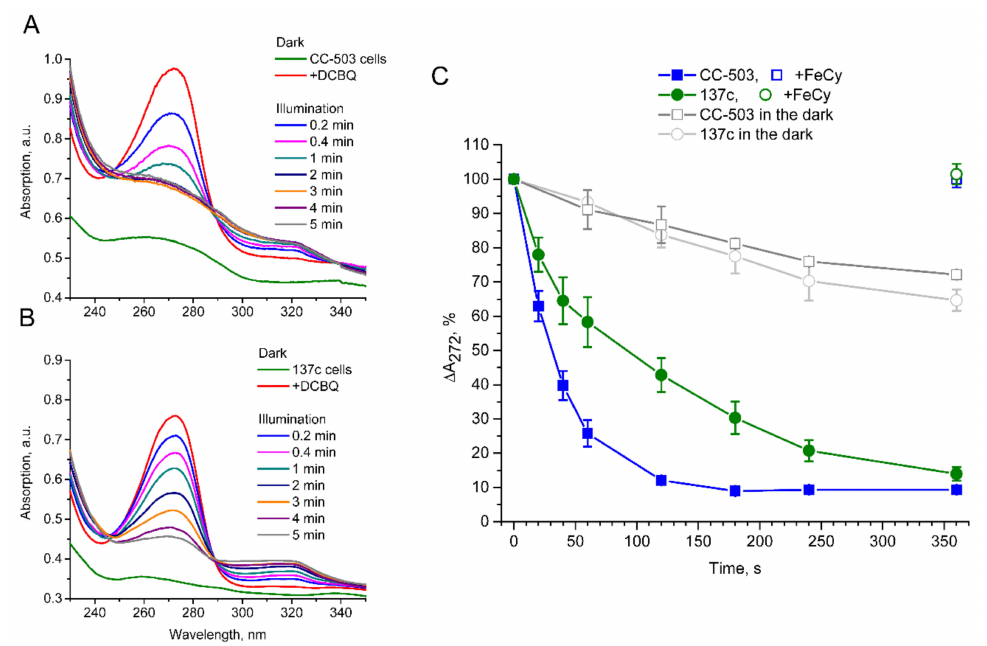
Figure 5. Light-induced reduction in DCBQ in the presence of living algal cells of C. reinhardtii . Panels ( A , B ), referring to the CC-503 and 137c, respectively, show the absorption changes in cell